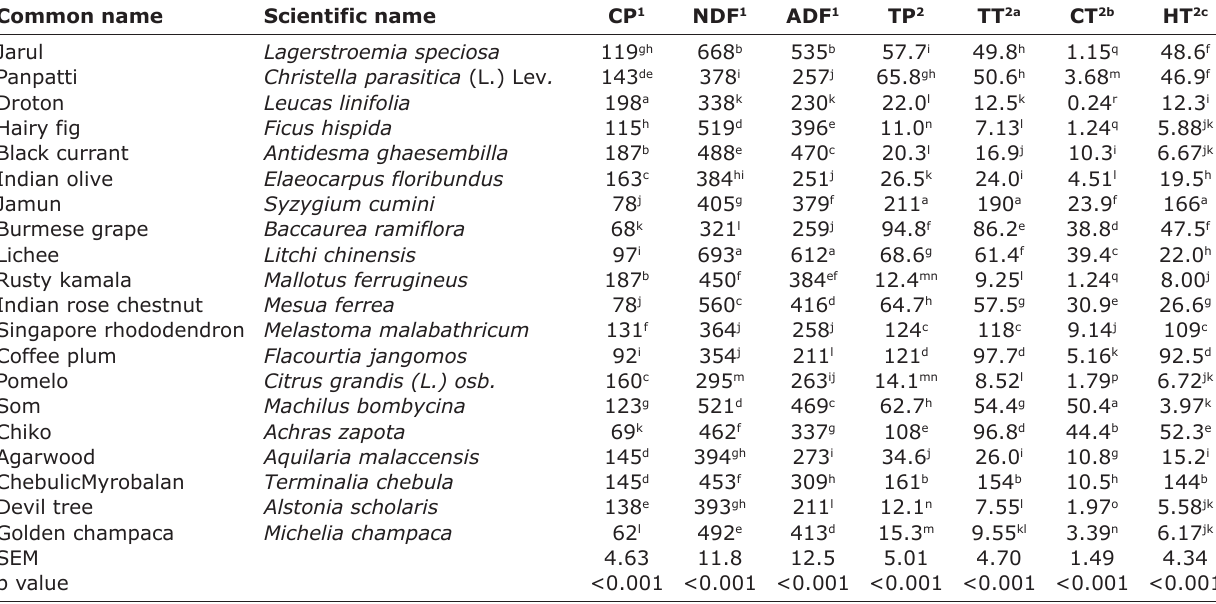
Table-1: Nutrient content and phenol content of medicinal plant leaves (g/kg DM) from Northeast state,